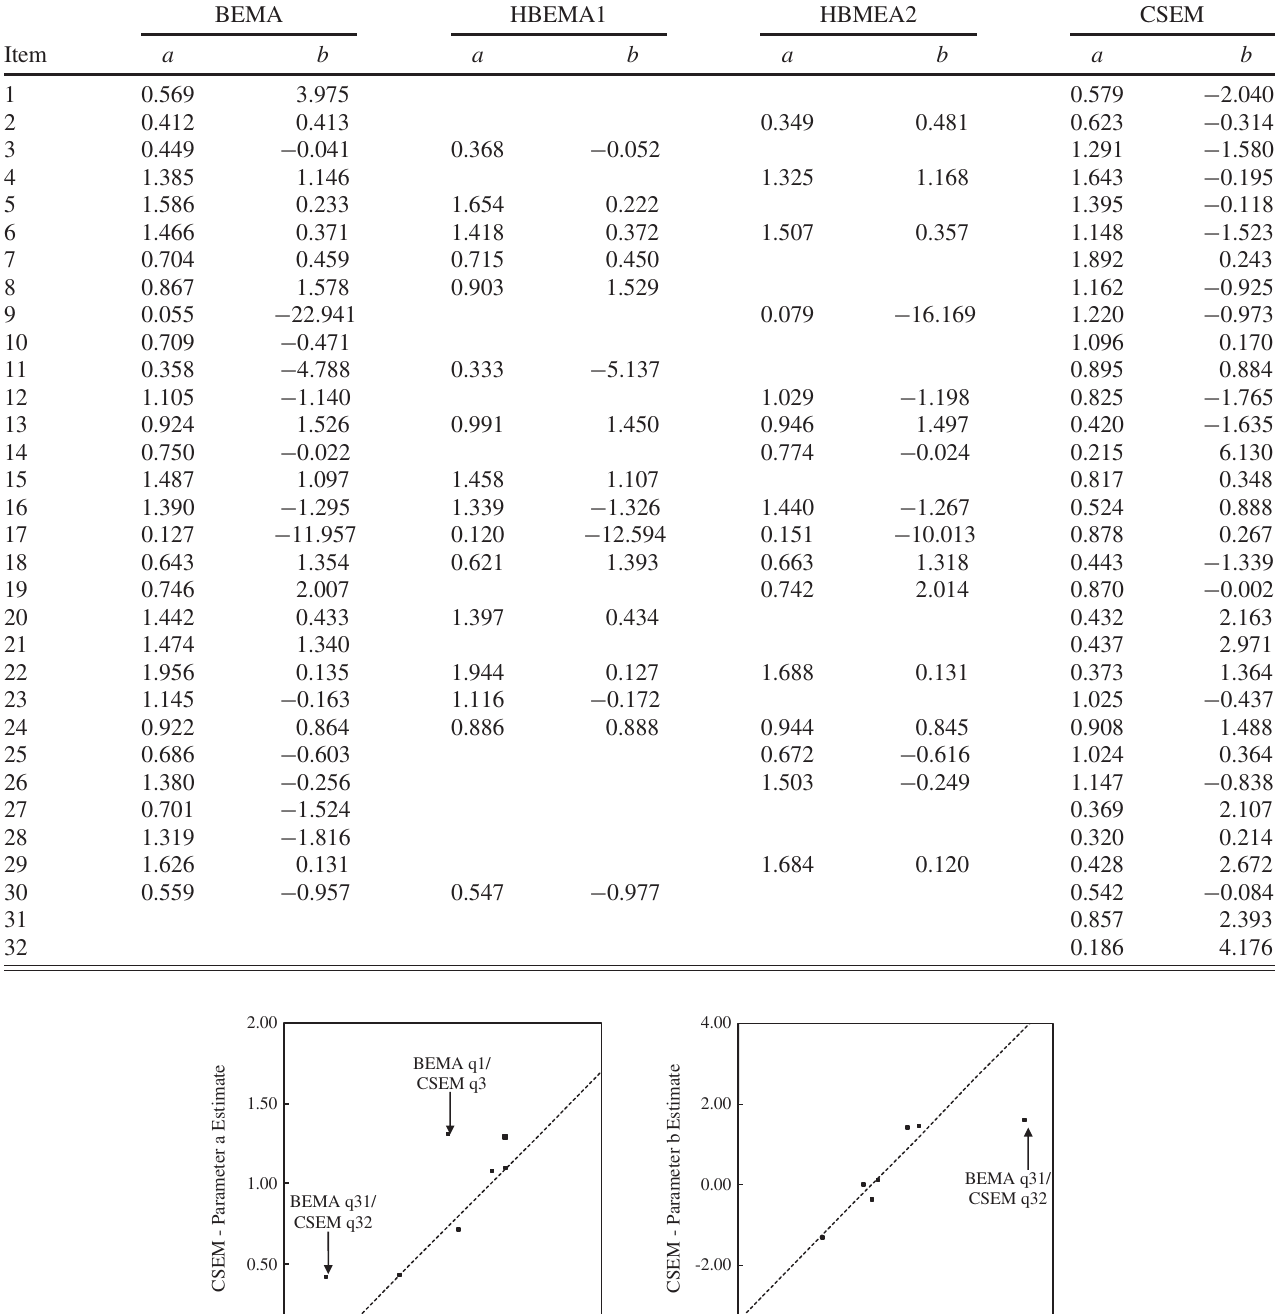
TABLE X. Item parameters for BEMA, HBEMA1, HBEMA2, and CSEM obtained in this study. The item numbers are consistent with the order of the original BEMA ( N ¼ 30 ) or CSEM ( N ¼ 32 ).